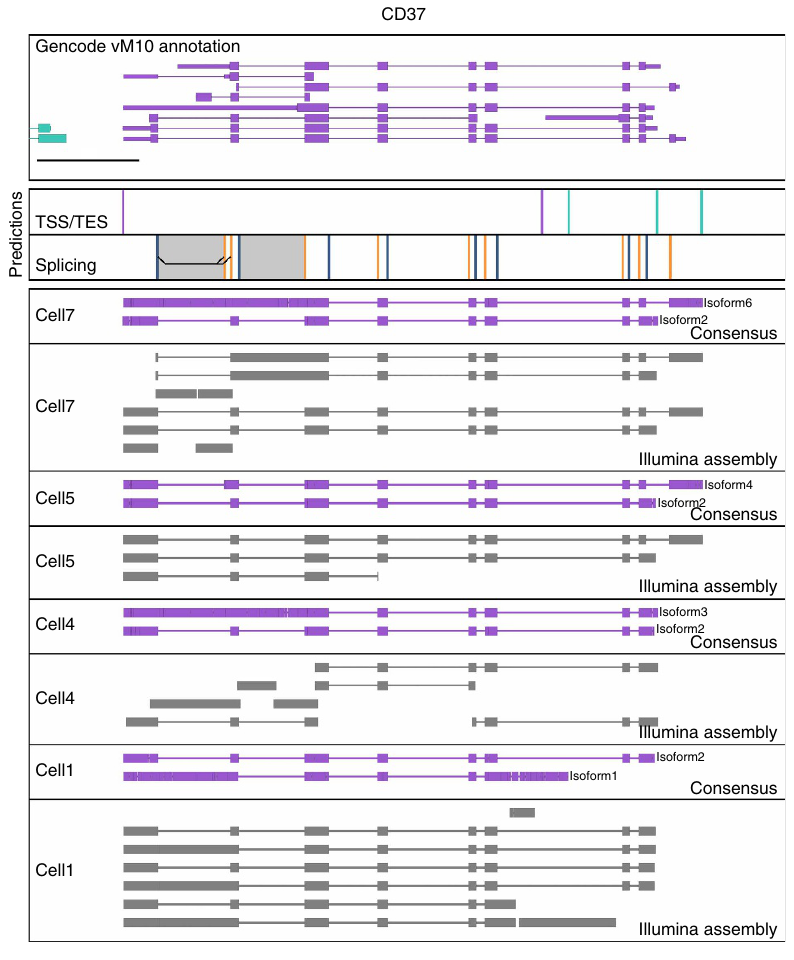
Figure 6 | Uncovering isoform diversity in B cell surface receptors. Genome Browser view of the CD37 is shown as in Fig. 4. In addition to isoform consensus derived from ONT 2D reads, contigs assembled from Illumina data using Trinity are shown in grey for the indicated